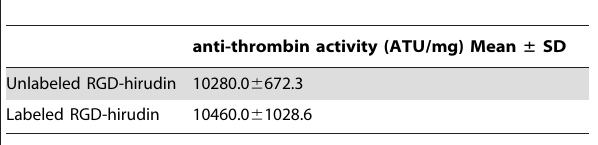
Table 2. The anti-thrombin activity of purified unlabeled and 15 N, 13 C-labeled RGD-hirudin.